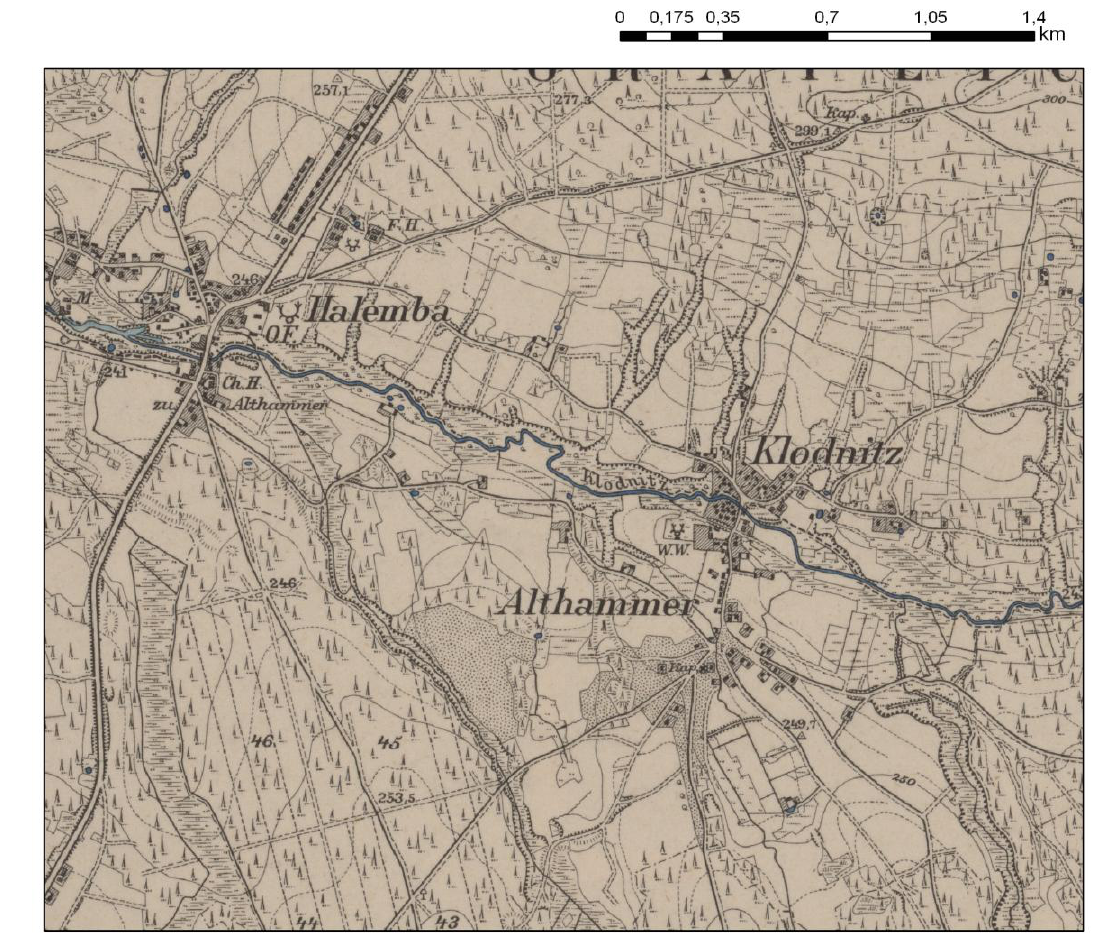
Fig. 4. Fragments of Messtischblätt, sheet Swietochowitz no. 3353, draw-up year